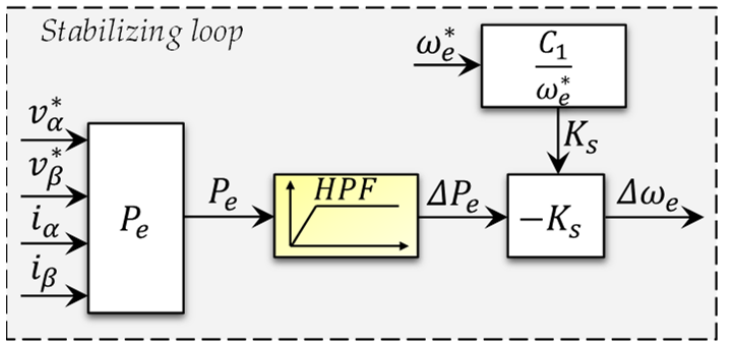
Figure 15. Block diagram of the stabilizing loop based on active power calculation.